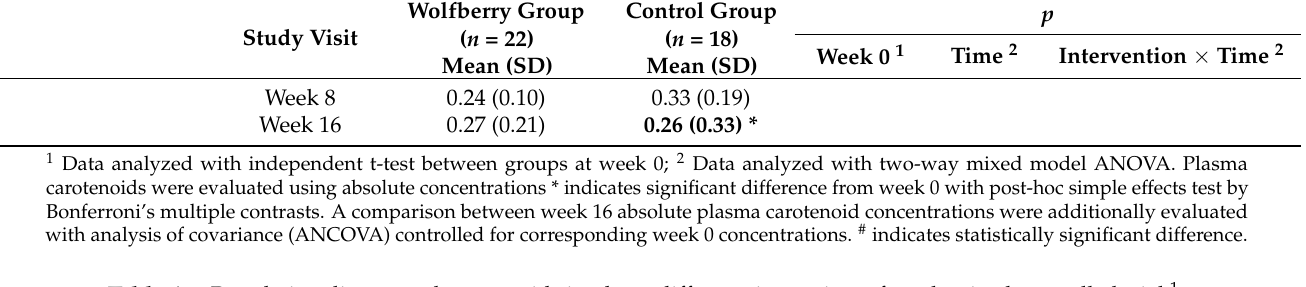
Table A2. Population dietary and carotenoids intake at different time points of randomized controlled trial 1 . Dietary Factors